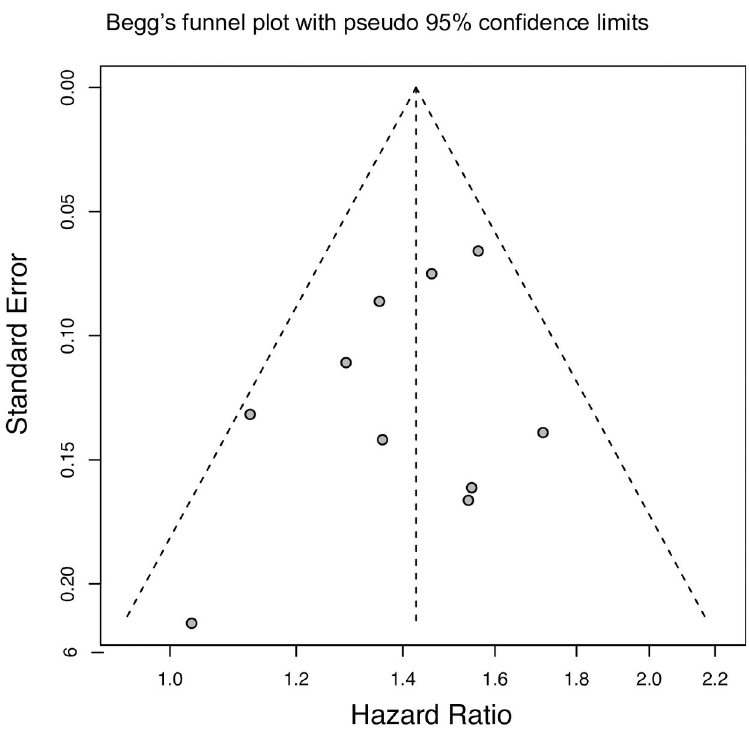
Fig 4. Funnel plot of studies correlating overall survival and CD25 expression in AML patients.